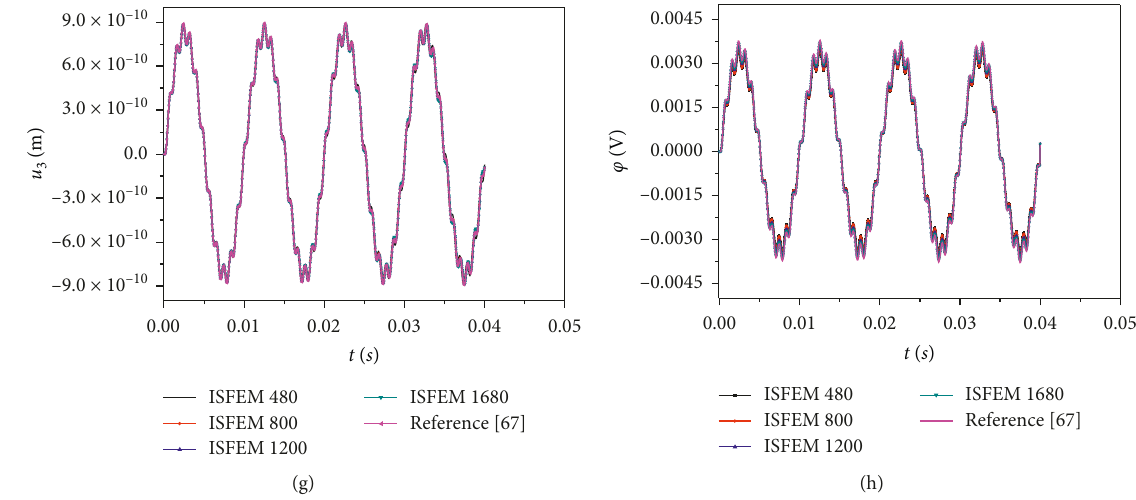
Figure 6: Variations of the displacement u 3 and electrical potential φ at the loading point with time when the gradient parameter was n � − 1, 0, 1, and 5. (a) Displacement ( n � − 1). (b) Electrical potential ( n � − 1). (c) Displacement ( n � 0). (d) Electrical potential ( n � 0).